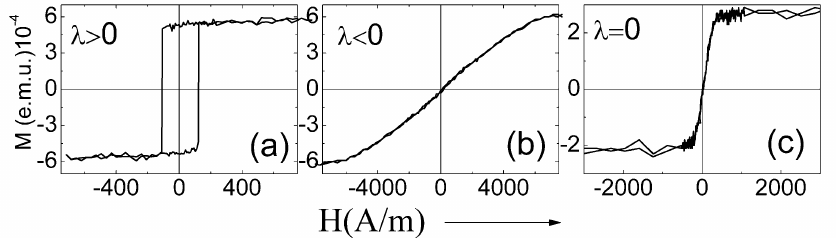
Figure 3. Hysteresis loops of Fe-rich ( λ microwires [38].